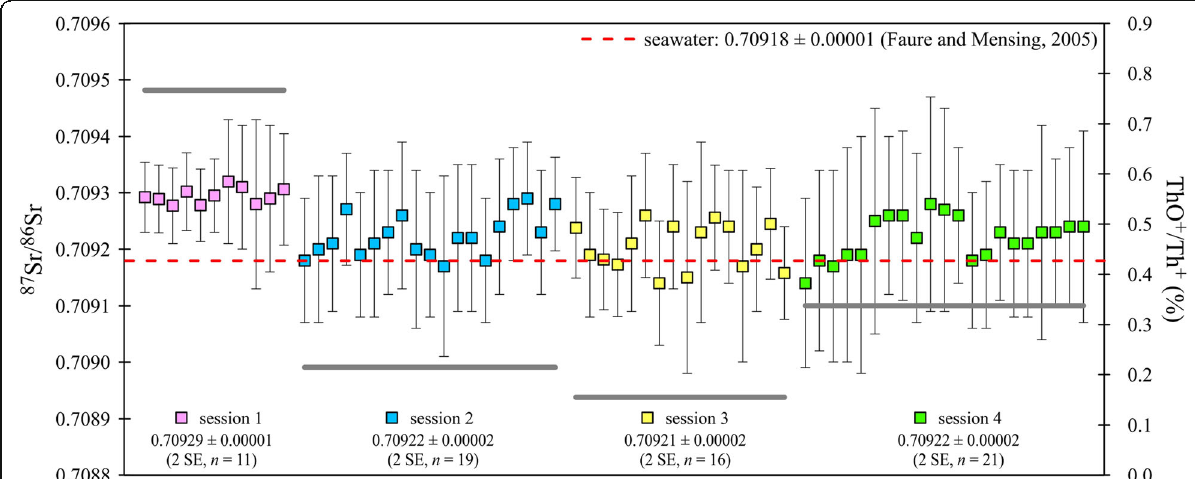
Fig. 2 87 Sr/ 86 Sr ratios obtained via LA-MC-ICPMS for the shark teeth assuming equal mass bias factors for Rb and Sr. Vertical error bars denote 2 standard errors. The dashed line represents the modern seawater value ( 87 Sr/ 86 Sr = 0.70918; Faure and Mensing 2005). The ThO + /Th + ratios measured before the beginning of each analytical session are marked as thick gray